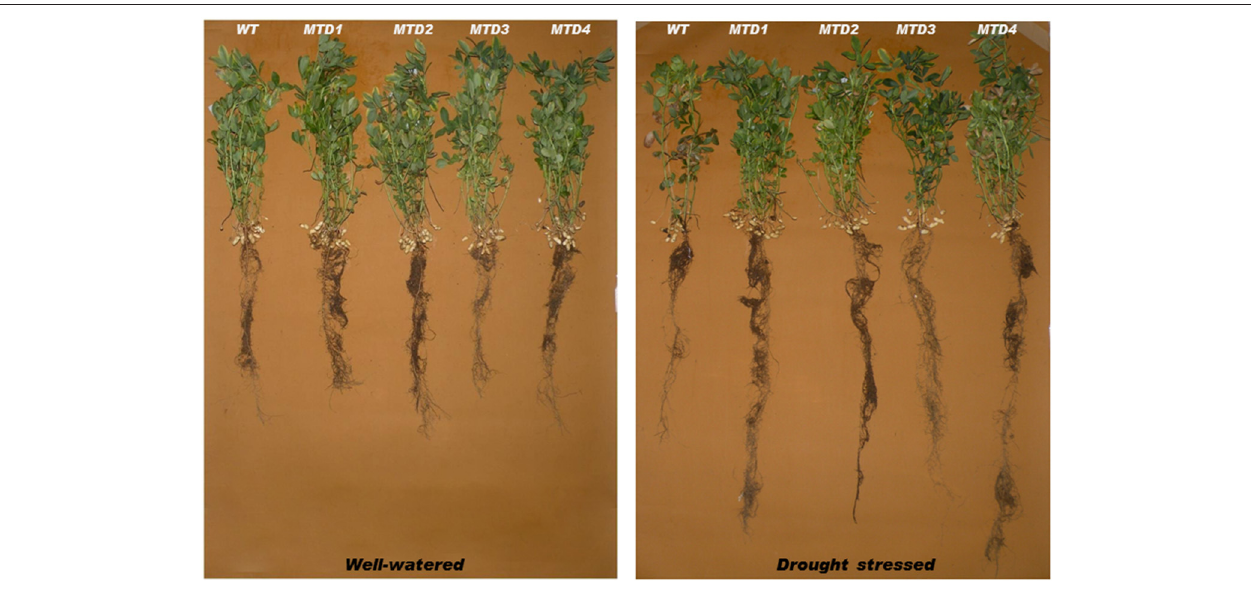
FIGURE 5 | Variations in root growth between wild-type and transgenic lines under well-watered and drought-stressed condition after harvesting.